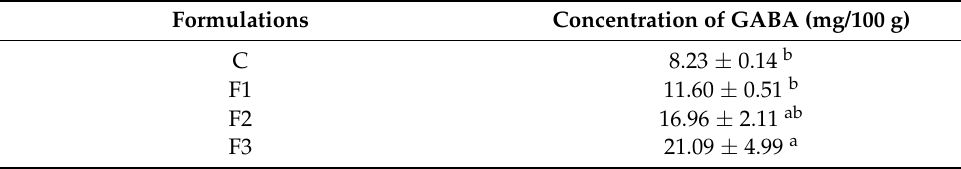
Table 3. GABA content of control and GABA-enriched dark